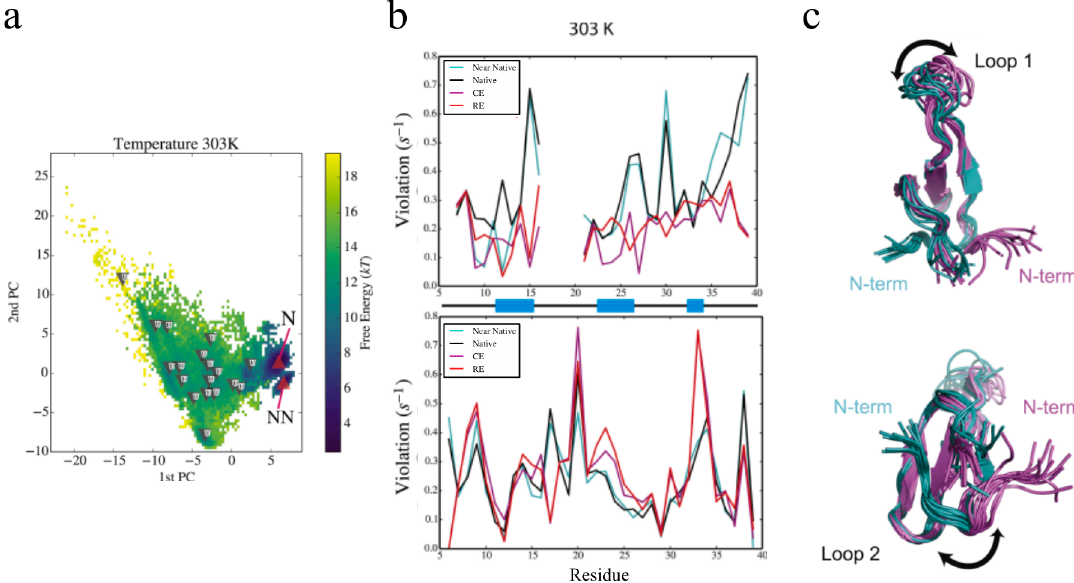
Figure 7. The eNOE is sensitive to minor populated states in the Pin1 WW domain. ( a ) Free-energy landscapes and cluster populations from replica-exchange molecular dynamics (MD) simulations and maximum entropy-based chemical shift reweighing carried out at 303 K are shown. The upward facing red triangles indicate cluster centroids that have a higher population in the reweighed ensemble (RE) than the canonical ensemble. The downward pointing triangles indicate clusters that have a lower population. For more information, see reference [35]; ( b ) Root-mean-square deviation (RMSD) violations of cross-relaxation rate constants from bidirectional (top) and unidirectional (bottom) eNOEs from REs and canonical ensembles (CEs), as well as from the native and near-native conformational clusters at 303 K. RMSD violations of 0.1–0.2 s —1 translate into distance errors of approximately 0.3–0.4 Å. Secondary structure by residue (black lines indicate loops and coiled regions, and blue blocks indicate β strands) are shown on x -axis; ( c ) The conformational changes inherent to the native and near-native states are depicted by calculated structural ensembles. The change in loop 1 (residues 17–20, top) of the WW domain and the topological rearrangement of the N and C termini (bottom) are especially prevalent. Ten conformers are shown in each cluster. This figure was adapted from [35], Copyright (2016), with permission from Cell Press.